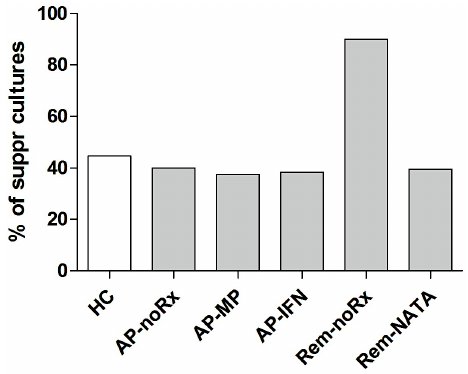
Figure 8. Percentage of cultures showing a suppressive shift in HC and patient groups, after culture with the antigenic peptides (PEP1-4, cP7). Note the significant increase in Rem-noRx patients.